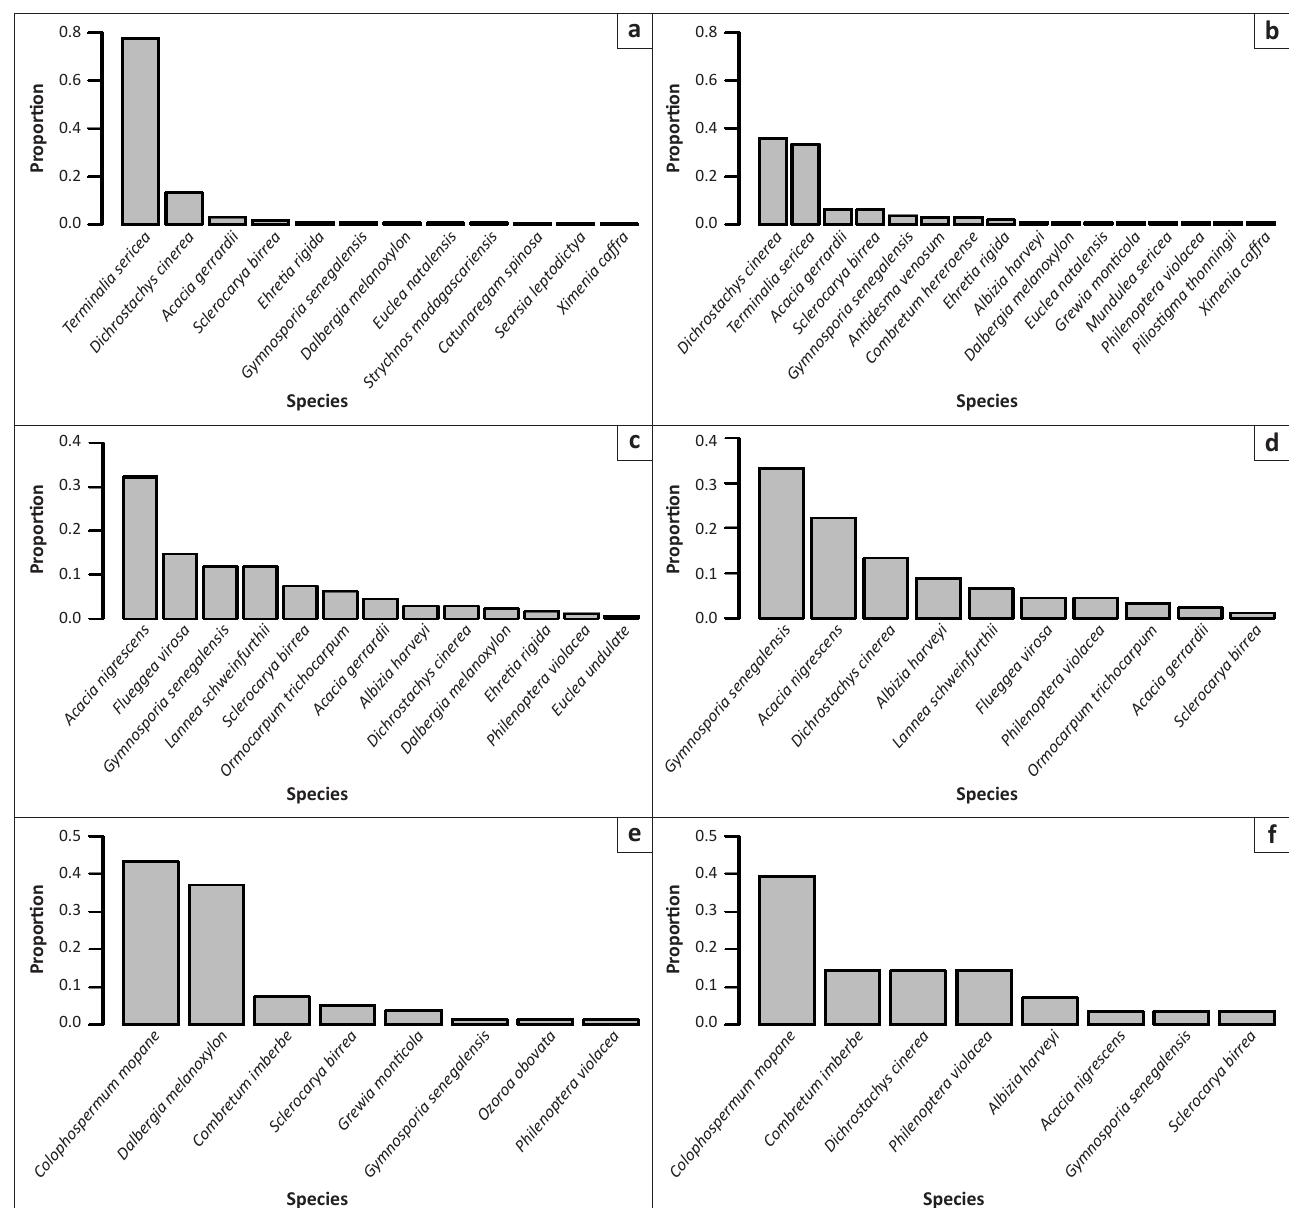
FIGURE 1: The relative abundance of the species found inside and outside the three exclosures namely Nhlangwini (a) inside and (b) outside, Makhohlola (c) inside and (d) outside and N’waxitshumbe (e) inside and (f) outside, in the Kruger National